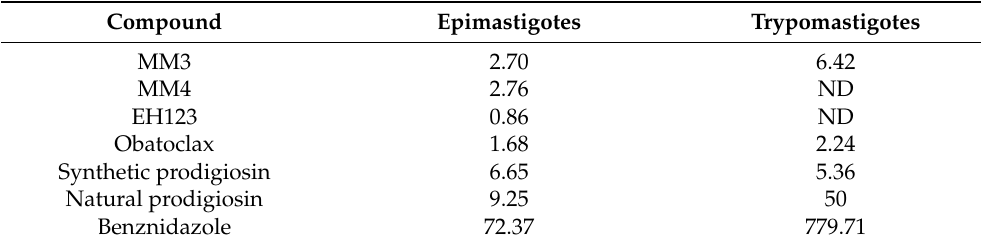
Table 6. Selectivity index (SI) of tambjamines, Obatoclax, synthetic and natural prodigiosins, and benznidazole against the two forms of T.cruzi (CLB strain).